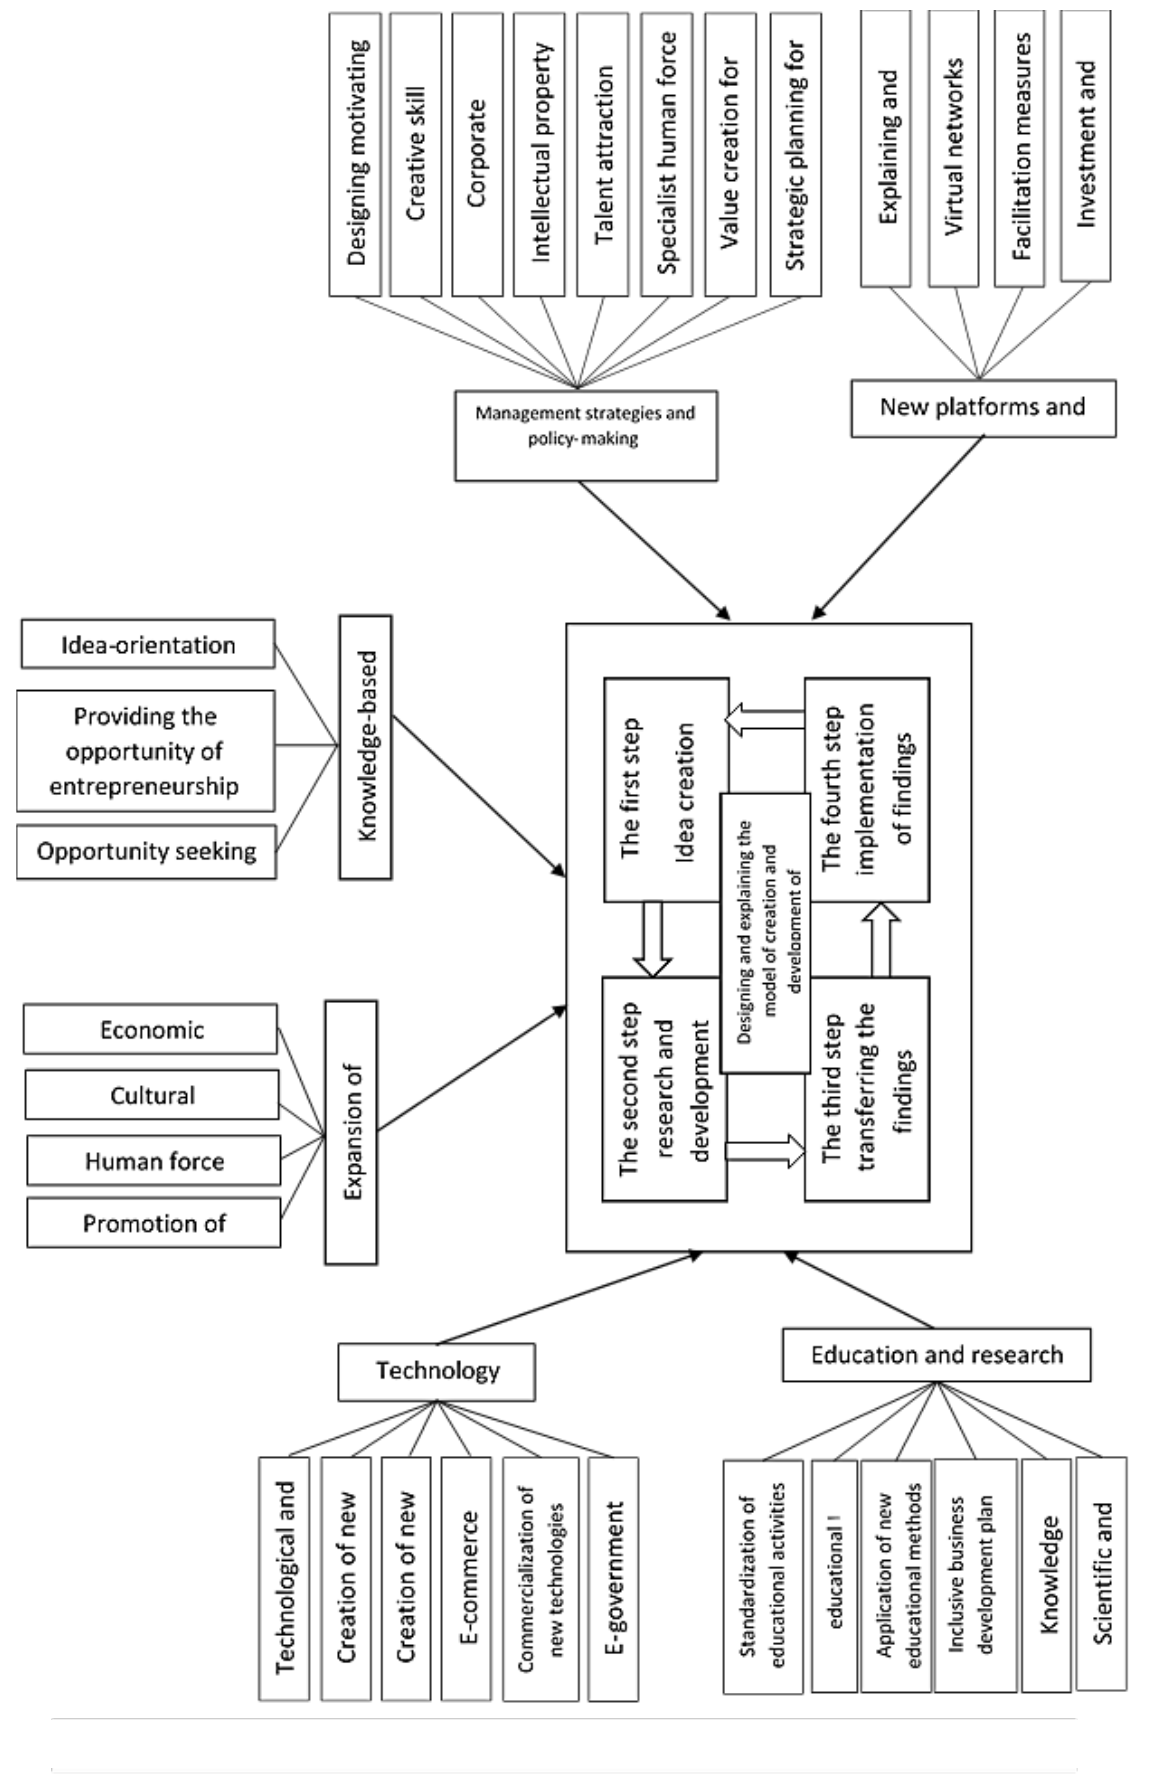
Fig. 2. The final model of creation and development of knowledge-based